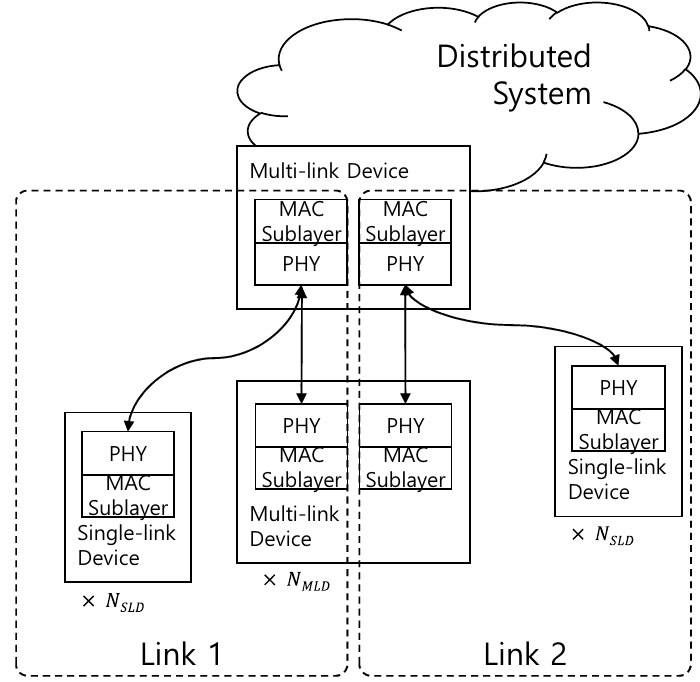
Figure 9. Topology for the